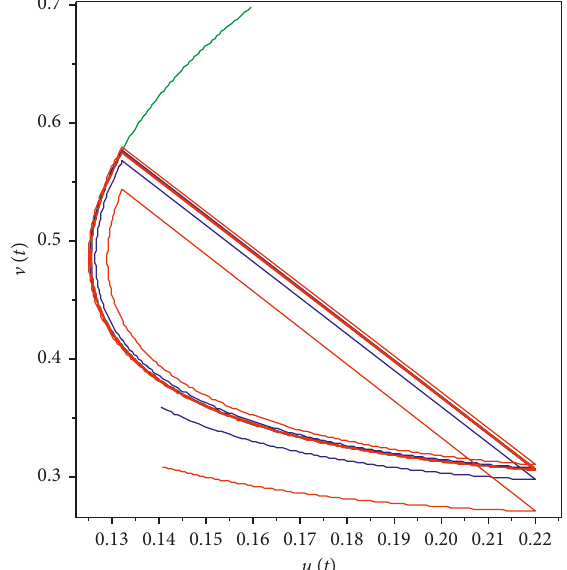
Figure 5: State pulse feedback control strategy of system (5): s � 2, A � 0 . 5, δ � 1, d � 0 . 25, k D � 1, and with three different initial